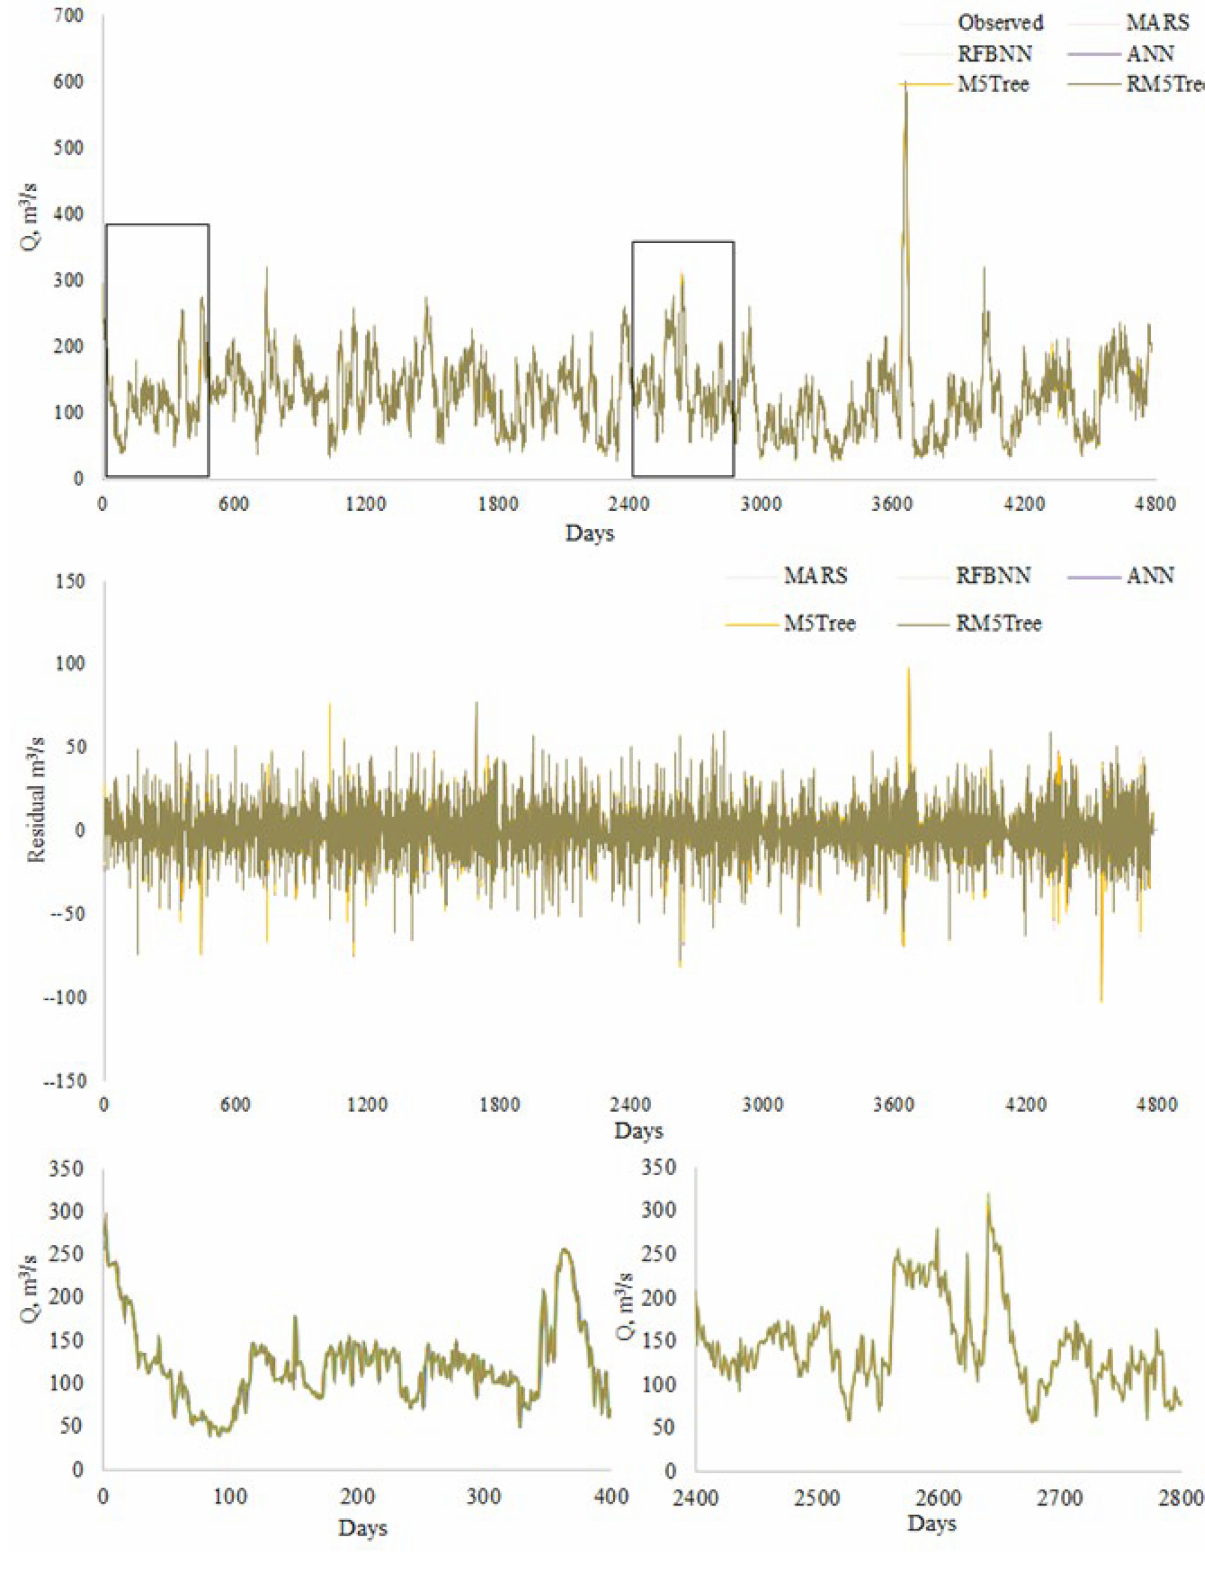
Figure 7. Time variation graphs of the predicted streamflow by RM5Tree, M5Tree, RBFNN, ANN, and MARS models in the test period of Skallbole Station